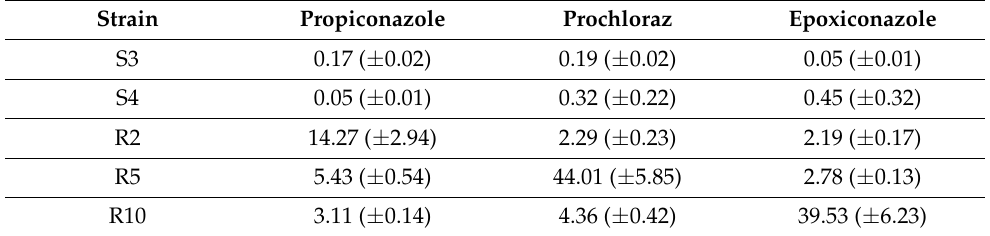
Table 2. Results of fungicide sensitivity assays. EC 50 values (in µ g/mL) were calculated using Graph Pad Prism software (9.0.0), based on mean colony diameter and radial growth of each strain. Strain